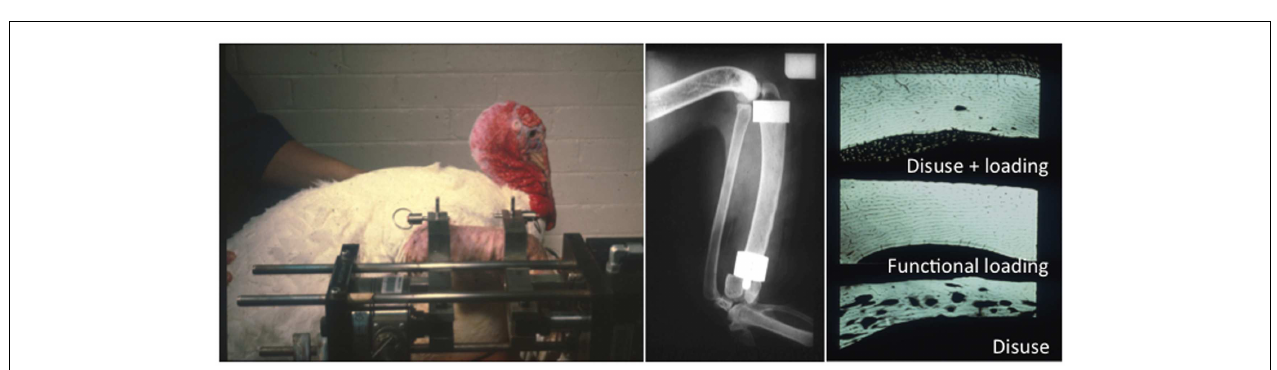
FIGURE 4 |The functionally isolated invasive turkey loading model . Lanyon and Rubin further applied the invasive loading model to the functionally isolated avian ulna, which had the advantage that the loaded bone is isolated from the confounding influence of background strain stimuli (46–48).